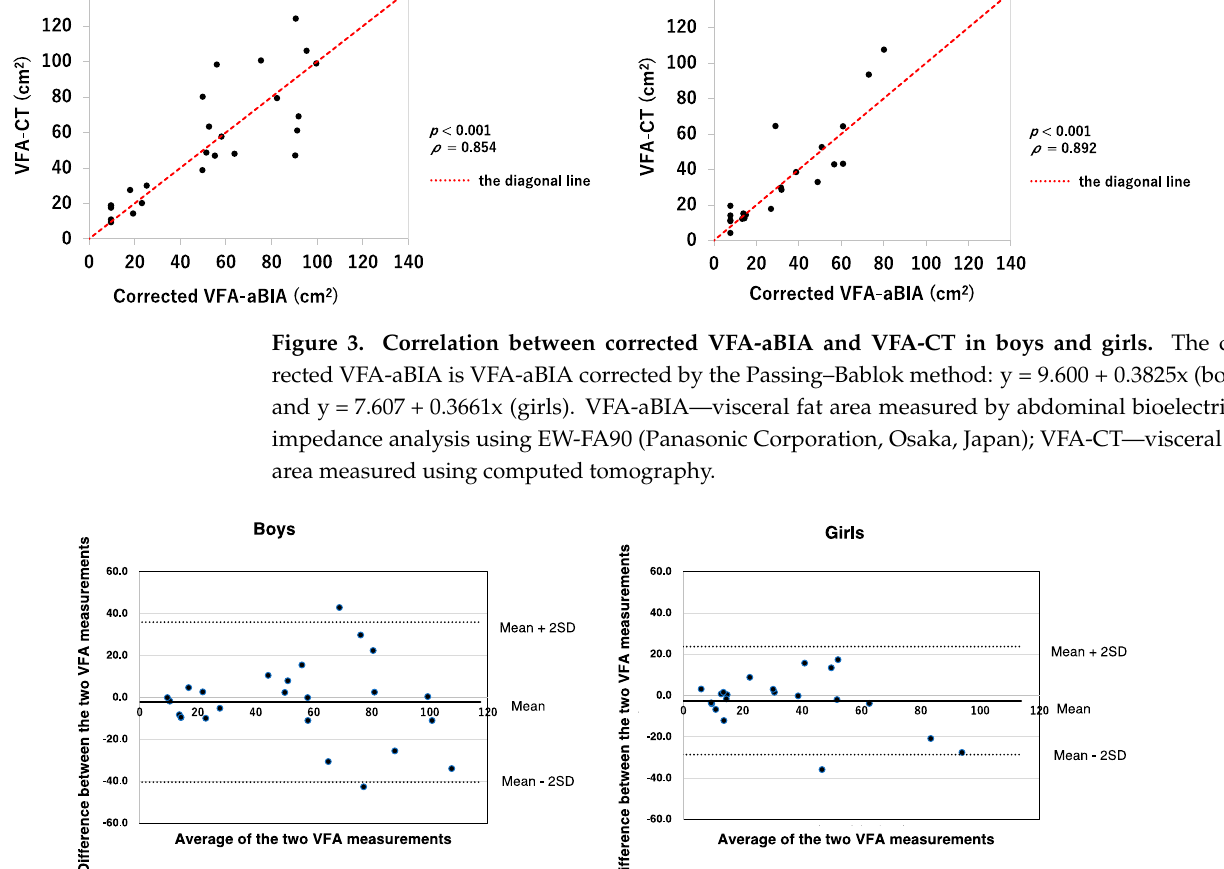
Figure 4. The Bland–Altman plots for corrected VFA-aBIA and VFA-CT in boys and girls. SD—standard deviation; VFA-aBIA—visceral fat area measured by abdominal bioelectrical impedance analysis using EW-FA90 (Panasonic Corporation, Osaka, Japan); VFA-CT—visceral fat area measured using computed tomography.